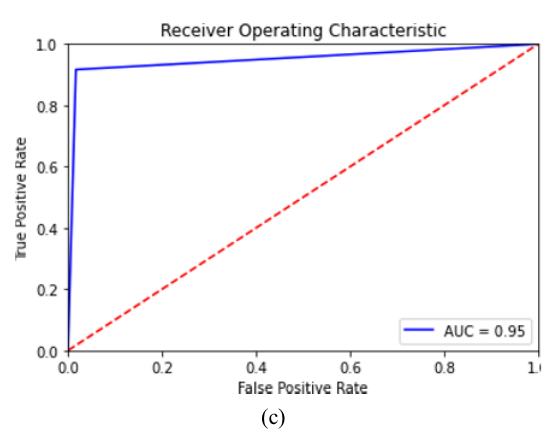
Fig. 6. accuracy of related work and proposed method